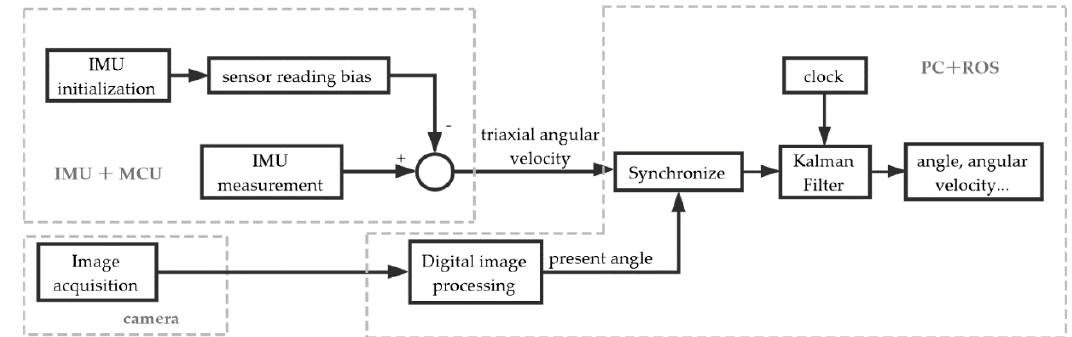
Figure 8. Test platform.